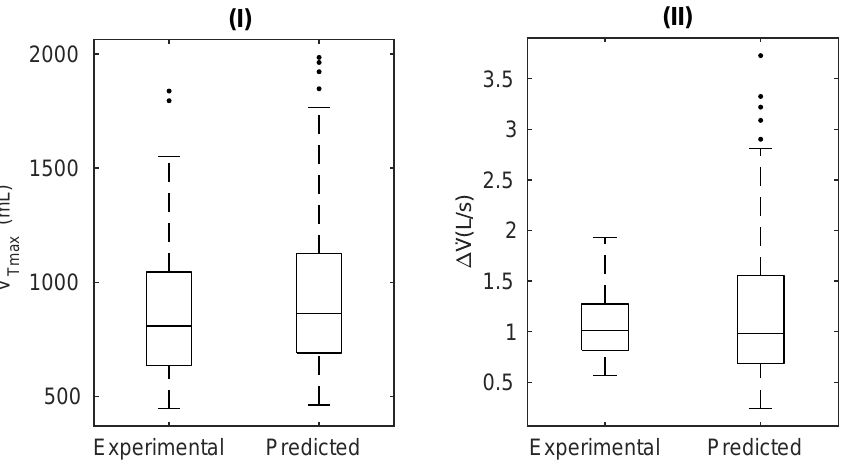
Figure 5. Airflow ( ˙ V ) and tidal volume (V Tmax ) variations to changes in R (graphs I and II) and C (graphs III and IV). Values for ˙ V and V Tmax are shown as changes regarding the basal value of each subject (i.e., variable values without applying any obstructions). Population curves emphasizing the experimental data are marked in blue. The curves of Tests A, B, and C were constructed using fixed values for C (graphs I and II) and R (graphs III and IV), corresponding to quartiles Q1, Q2, and Q3 of the experimental data. For all tests, P musc was set to 8 cmH 2 O and RR to 12 bpm. Solid lines denote the linear fits of each group for ( I ) ∆ ˙ V vs. ∆ R ; ( II ) ∆ V Tmax vs. ∆ R ; ( III ) ∆ ˙ V vs. ∆ C ; ( IV ) ∆ V Tmax vs. ∆ C .